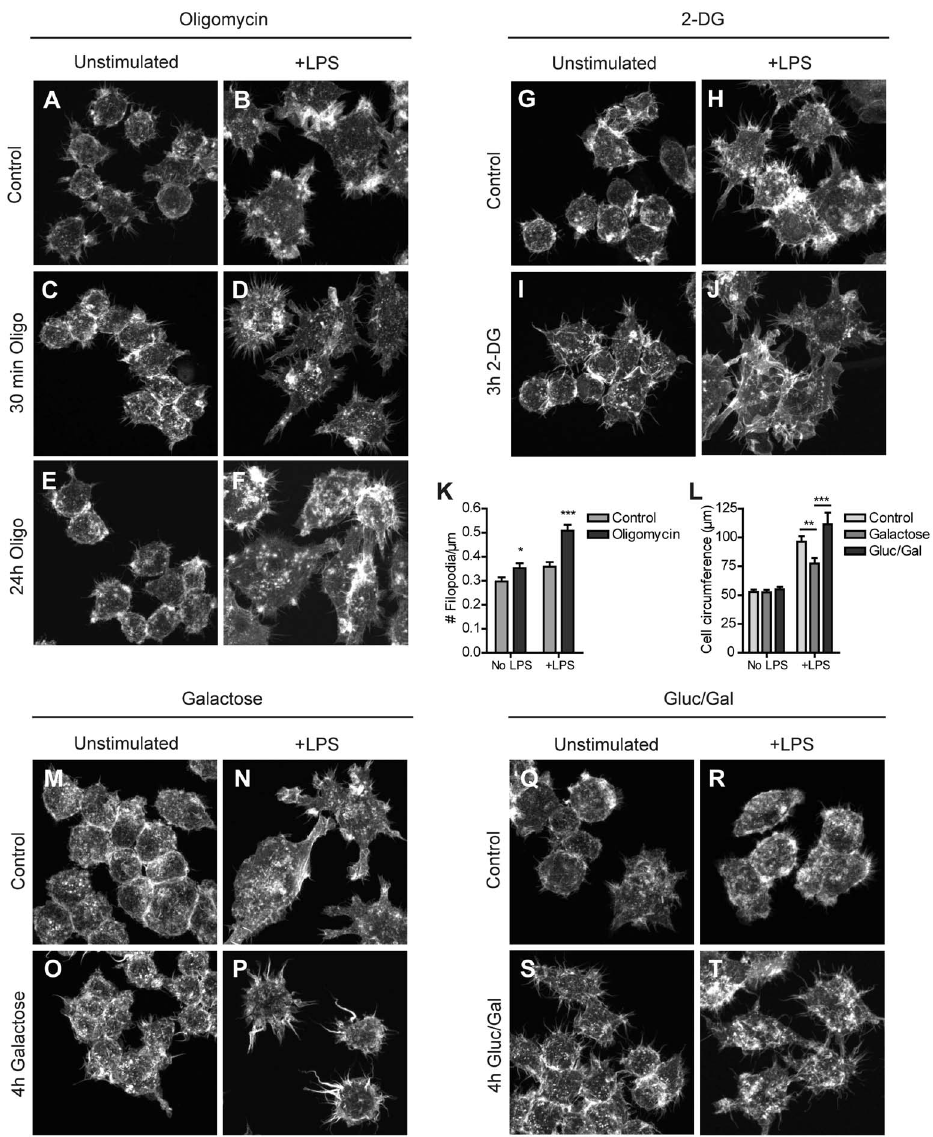
Figure 3. Actin cytoskeletal structural changes induced by inhibition of glycolysis or mitochondrial OXPHOS. RAW 264.7 cells were seeded on glass coverslips, incubated in control medium or medium containing 2.5 m M oligomycin and 25 mM glucose (A–F), 10 mM 2-DG and 25 mM glucose (G–J), 10 mM galactose and no glucose (M–P), or 1 mM glucose and 10 mM galactose (Q–T) for the indicated time periods and stimulated overnight with LPS or left unstimulated. After fixation in 2% PFA, cellular actin was stained with phalloidin-Alexa568 and cells were imaged on a Zeiss LSM510 meta confocal laser scanning microscope. The number of filopodia extending radially from the cell surface (expressed as # filopodia per m M contour length; see M&M) was determined for control cells and cells treated for 24 hours with oligomycin, in the presence and absence of LPS (K). The average cell circumference was determined for cells in control medium or medium containing 10 mM galactose, or 1 mM glucose and 10 mM galactose (L). (*p , 0.05, **p , 0.01, ***p , 0.001, unpaired